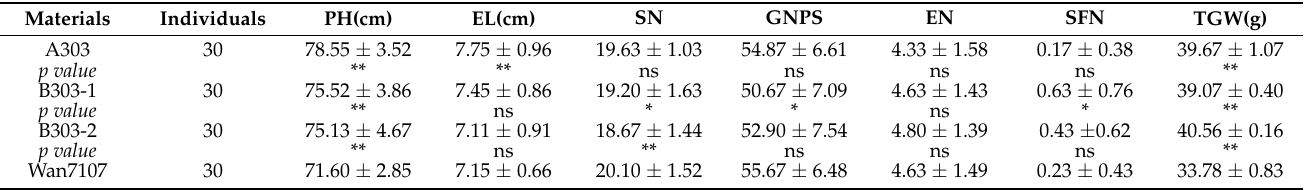
Table 4. Comparison of main agronomic traits between translocation lines and their recurrent parent Wan7107. Materials